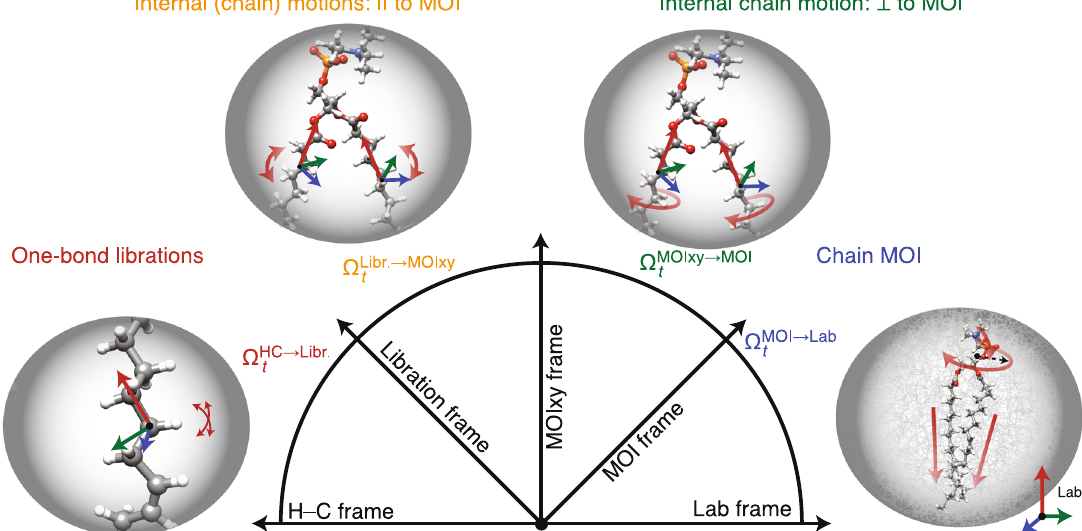
Fig. 3 Illustration of the series of frames used for separating the motion of an H – C bond in an acyl chain in POPC into components (concept ref. 27 ). One-bond librations are separated by de fi ning a frame that aligns the carbon of the H – C bond, and all atoms are directly bonded to that carbon. The motion of the bond within this frame de fi nes local librational motion. Within each chain, librational frames move within the MOIxy frames. Alignment of the MOIxy frame removes rotation around the moment of inertia (MOI), so that this motion only contains motion parallel to the MOI. The motion of the MOIxy frames within the MOI frame then only contains motion perpendicular to the MOI. Finally, the chain MOI frames move within the lab frame, capturing the overall motions of the given acyl